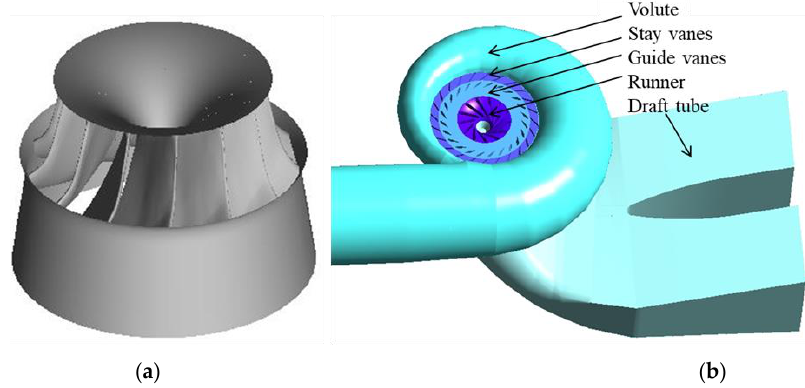
Figure 2. Sketch of the model. ( a ) Model of the runner; ( b ) Model of the whole passage.